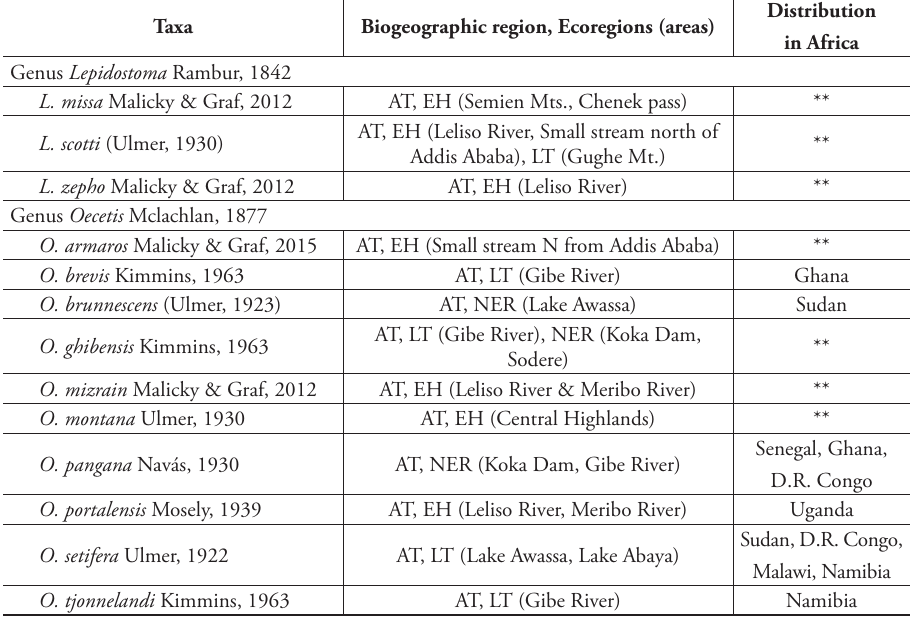
Table 1. Species of Lepidostoma and Oecetis occurring in Ethiopia following Kimmins (1963) and Malicky and Graf (2012, 2015); ecoregions according to Abell et al. (2008); distribution status from Tobias and Tobias (2008). AT, Afrotropical; EH, Ethiopian Highlands; LT, Lake Turkana; NER, Northern Eastern Rift; **, not reported outside of